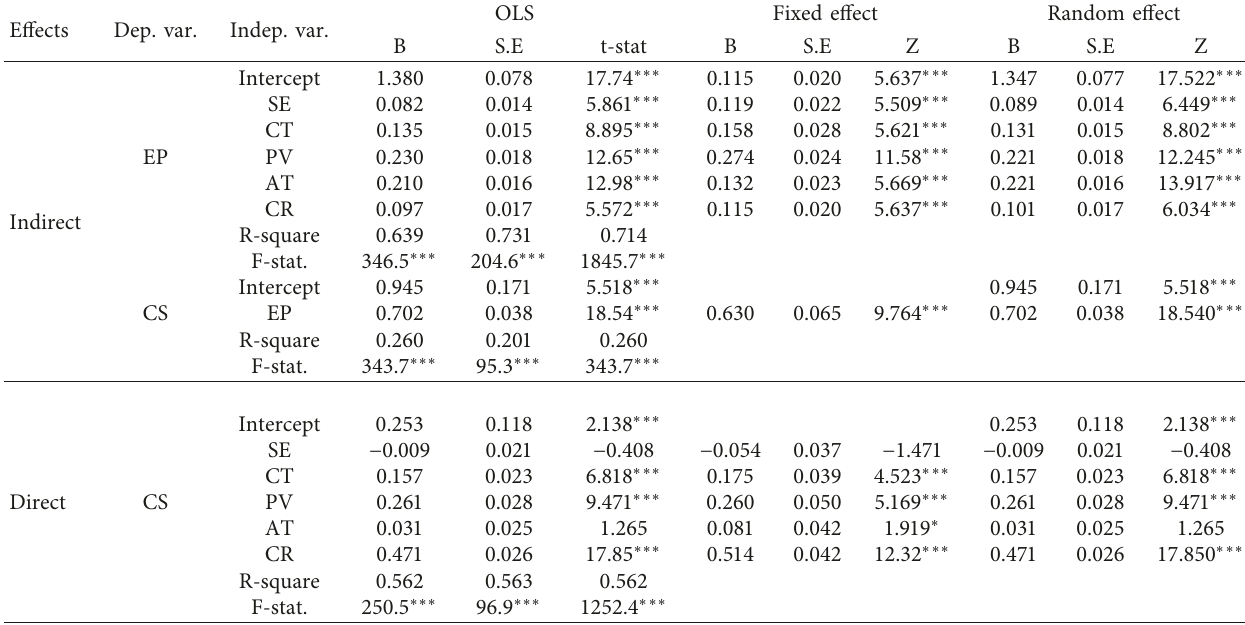
Table 5: The OLS, fixed effect, and random effect.